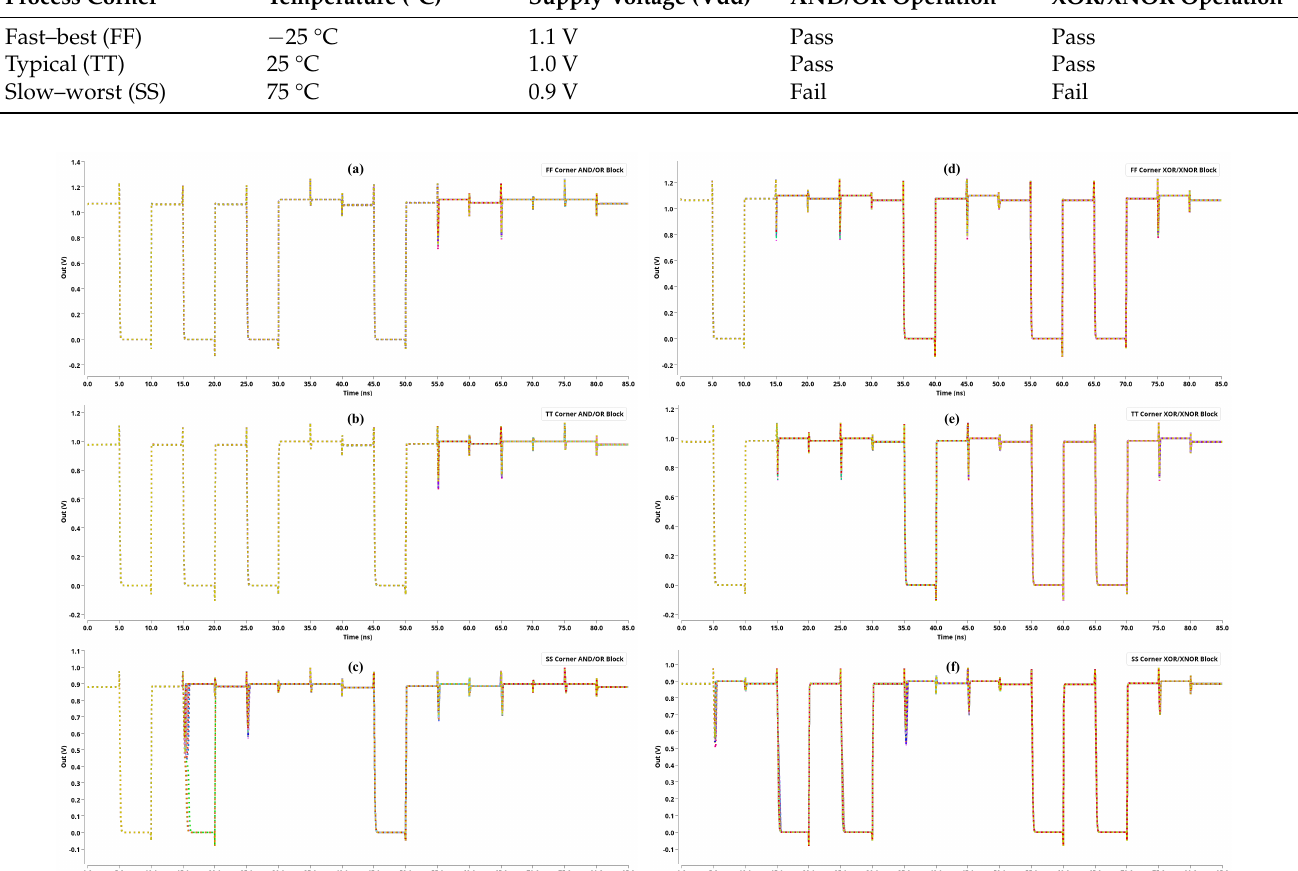
Figure 9. Monte Carlo simulation waveforms at ( a – c ) FF, TT, and SS corners in circuit performing AND/OR operation and ( d – f ) FF, TT, and SS corners in circuit performing XOR/XNOR